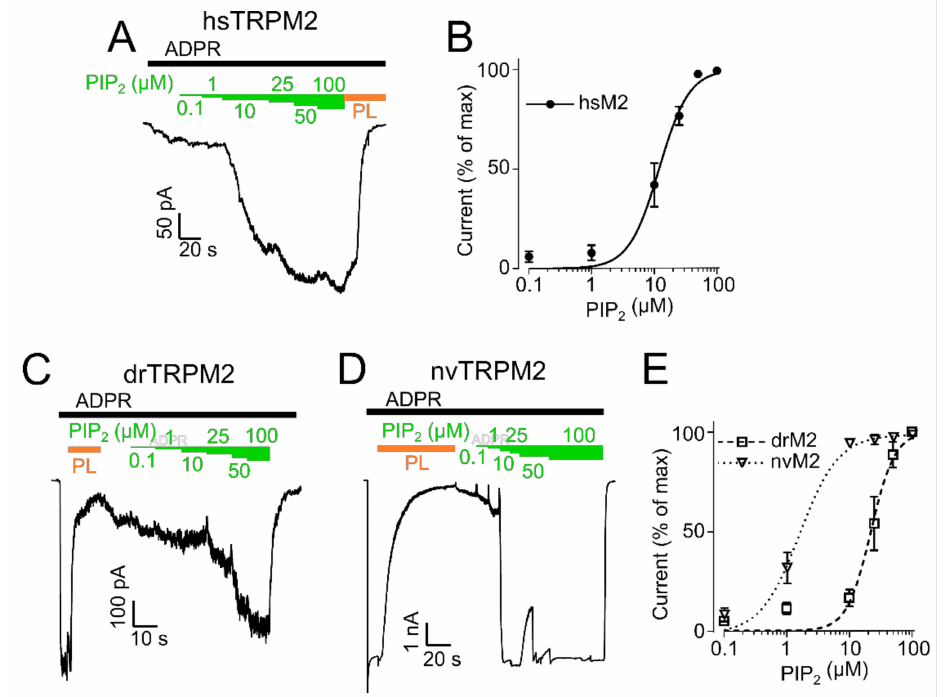
Figure 3. PIP 2 sensitivity of TRPM2. PIP 2 dose-response recordings of inside-out patches of HEK-293 cells expressing hsTRPM2 ( A ), drTRPM2 ( C ), and nvTRPM2 ( D ). ADPR (black bar) was used to initiate TRPM2 currents followed by increasing concentrations of PIP 2 (green bars). Polylysine (PL, orange bar) was utilized to scavenge PIP 2 . Summary of the PIP 2 dose-response recordings calculated as a percentage of the maximum current obtained at 100 µ M PIP 2 (hsTRPM2 ( B ), drTRPM2, and nvTRPM2 ( E )). Data were analysed from five to six independent